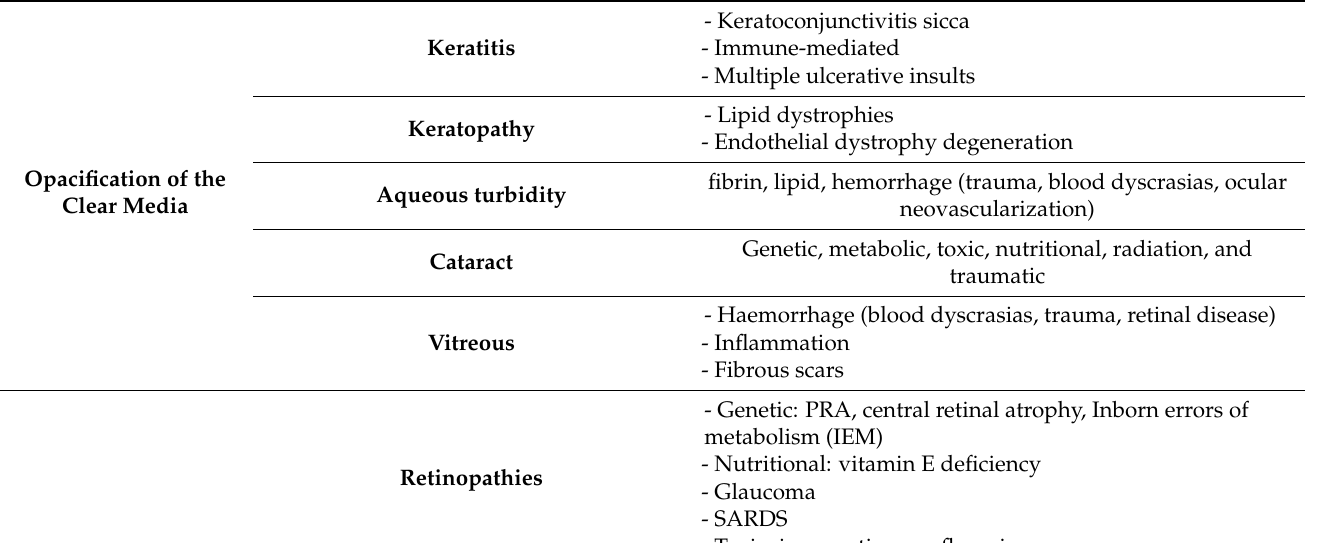
Table 1. The main causes that lead to blindness. Adapted from Martin, C.L, 2001